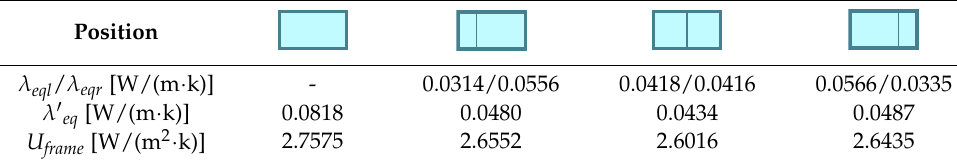
Table 3. Effect of RIP position on heat transfer from window frame.